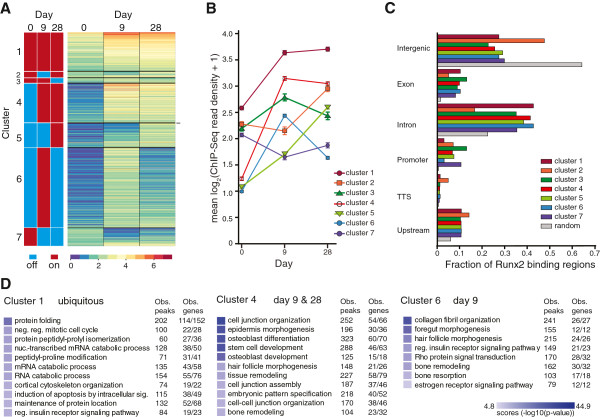
Characterization of the temporal patterns of Runx2 binding associated with osteoblastogenesis. (A) Enriched regions of Runx2 binding (MACS peaks, P ≤ 1 × 10-10) were grouped into seven clusters based on the presence (red) or absence (blue) of peaks at temporal stages of osteoblastic differentiation (left panel). In the right panel, each line illustrates intensity (base-2 logarithm of the sum of read counts per 10 million reads (mean read density)) of one peak as a range from strong occupancy (brown) to weak occupancy (violet). (B) Runx2 binding intensities of Runx2 peaks from each cluster at days 0, 9, and 28 of differentiation plotted as mean ± SEM. (C) Distribution patterns of the Runx2 peaks from each of the seven clusters (from (A)) segregated into six categories of genomic locations and compared to an equivalent number of random 100 bp regions (gray bar). (D) Representative Gene Ontology term annotation of cluster 4 (days 9 & 28) by GREAT. Each term is annotated with the observed (Obs.) number of Runx2 peaks and corresponding number of genes out of the total number of genes.